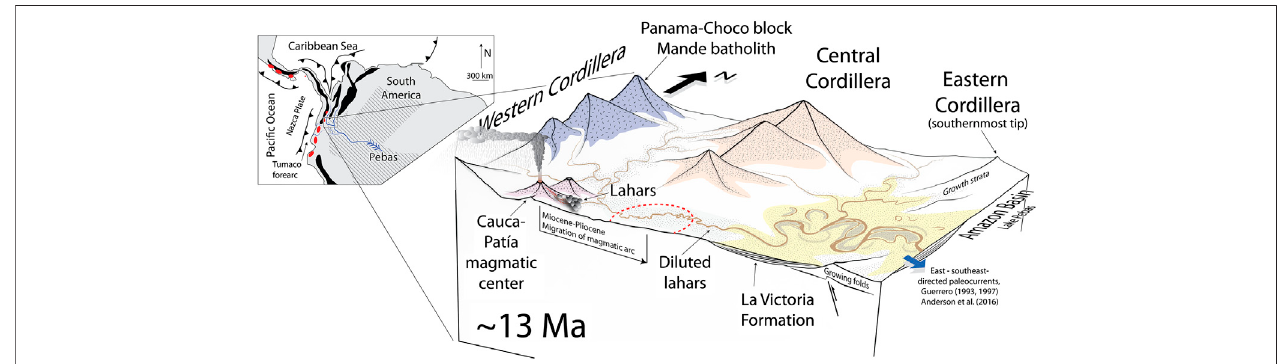
FIGURE12| Block-diagramillustratingapossiblepaleogeographicscenarioformiddleMiocenetimes( ∼ 13 Ma)intheTatacoaDesert.Lightyellowrepresentareas where subsidence and sediment accumulation took place. Dashed red line represents the future location of the Pliocene and younger magmatic arc of the Central Cordillera ( Figure 10 ). Detrital geochronology ( Figure 11 ), paleocurrent data (Guerrero, 1997; Anderson et al., 2016), and molecular fi sh data (Rincon-Sandoval et al., 2019) suggest connection of the volcanically active Cauca-Patia Basin (Leal-Mejia, 2011; Echeverri et al., 2015; Leal-Mejia et al., 2019), the recently accreted Panama-Choco block (Montes et al., 2015; Leon et al., 2018), with the Tatacoa Desert, itself connected to westernmost Amazonia ’ s Pebas system. Dominant wind directions according to Sepulchre et al. (2009). Inset shows palinspastic reconstruction of the margin at the same time (Montes et al., 2019), showing signi fi cant relief in black (Montes et al., 2015; Witt et al., 2017), Pebas system extent and drainages in diagonal pattern (Lundberg and Chernoff, 1992; Wesselingh et al., 2001; Jaramillo et al., 2017a; Kern et al., 2020), and active magmatic centers in red (Echeverri et al., 2015; Bineli-Betsi et al., 2017; Wagner et al., 2017).